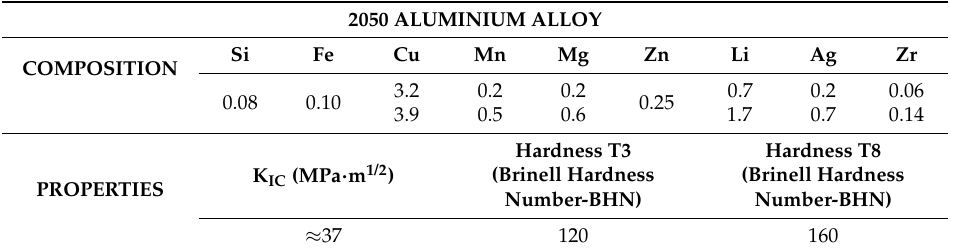
Table 1. Aluminum alloy (2050) chemical composition and standard